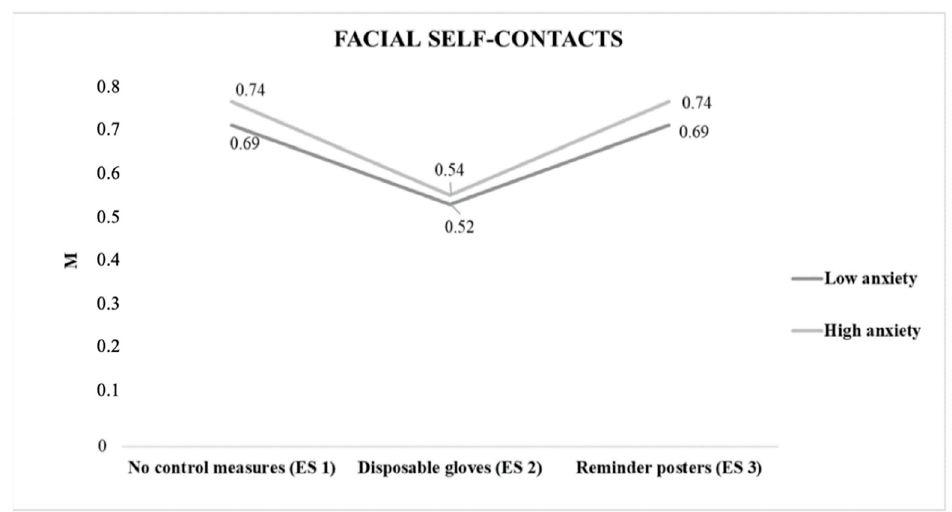
Figure 2. Average number of self–contacts per minute in different experimental situations according to anxiety levels. Note: ES = experimental situation. ES 1 (no control measures), ES 2 (disposable gloves), ES 3 (reminder posters). And as can be seen in Figure 3, intra–group differences were found (F (1,2) = 6.61, p < 0.01, η 2 = 0.04, observed potency = 0.87) and inter–group (F (1,2) = 25.38, p < 0.01, η 2 = 0.14, observed potency = 0.99).